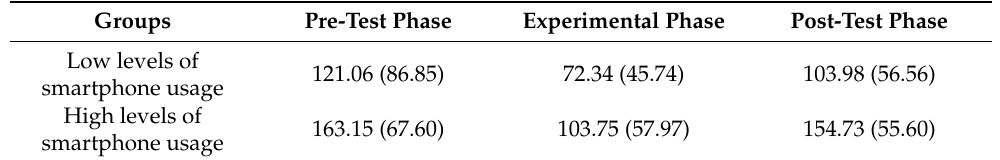
Table 1. Means (and standard deviations) of total minutes of smartphone use in the three phases.